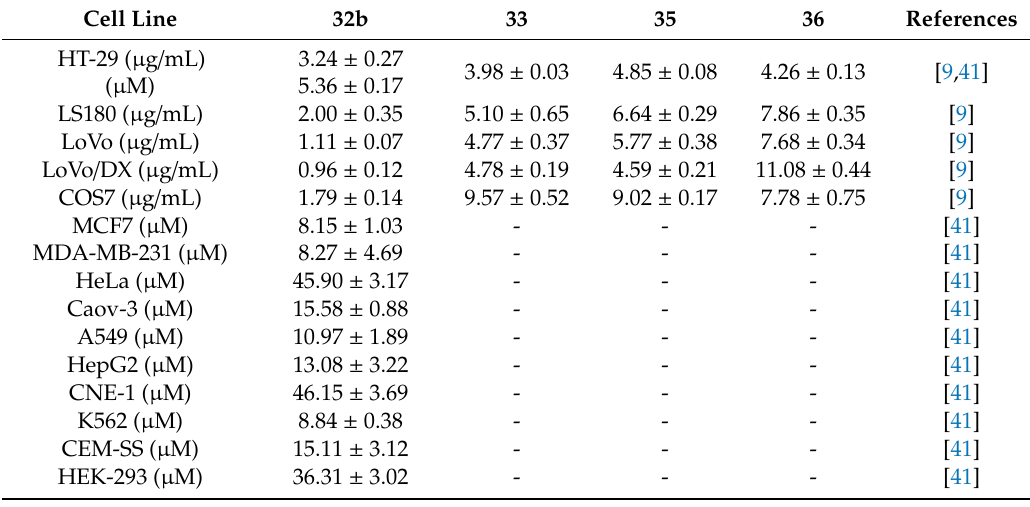
Table 12. Anticancer activity of 2-aminochalcones 32b , 33 , 35 , and 36 (IC 50